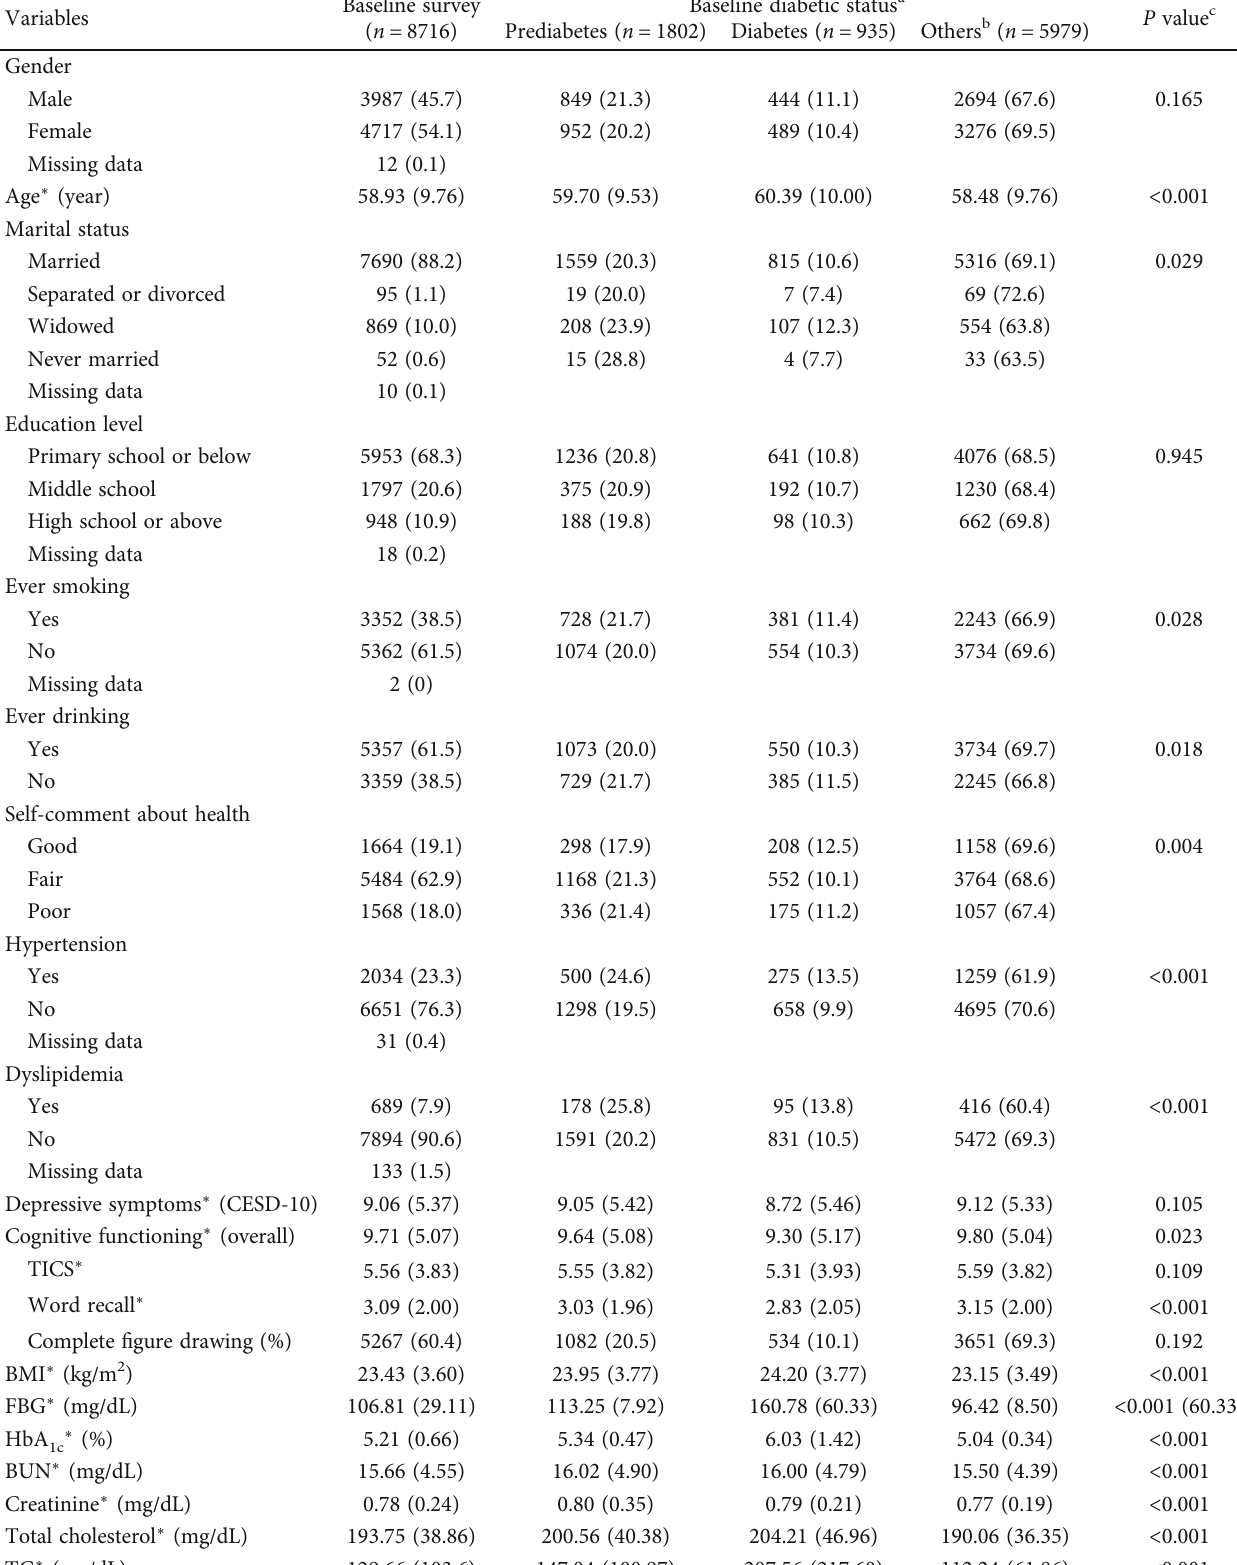
Table 1: Baseline characteristics of participants with di ff erent diabetic